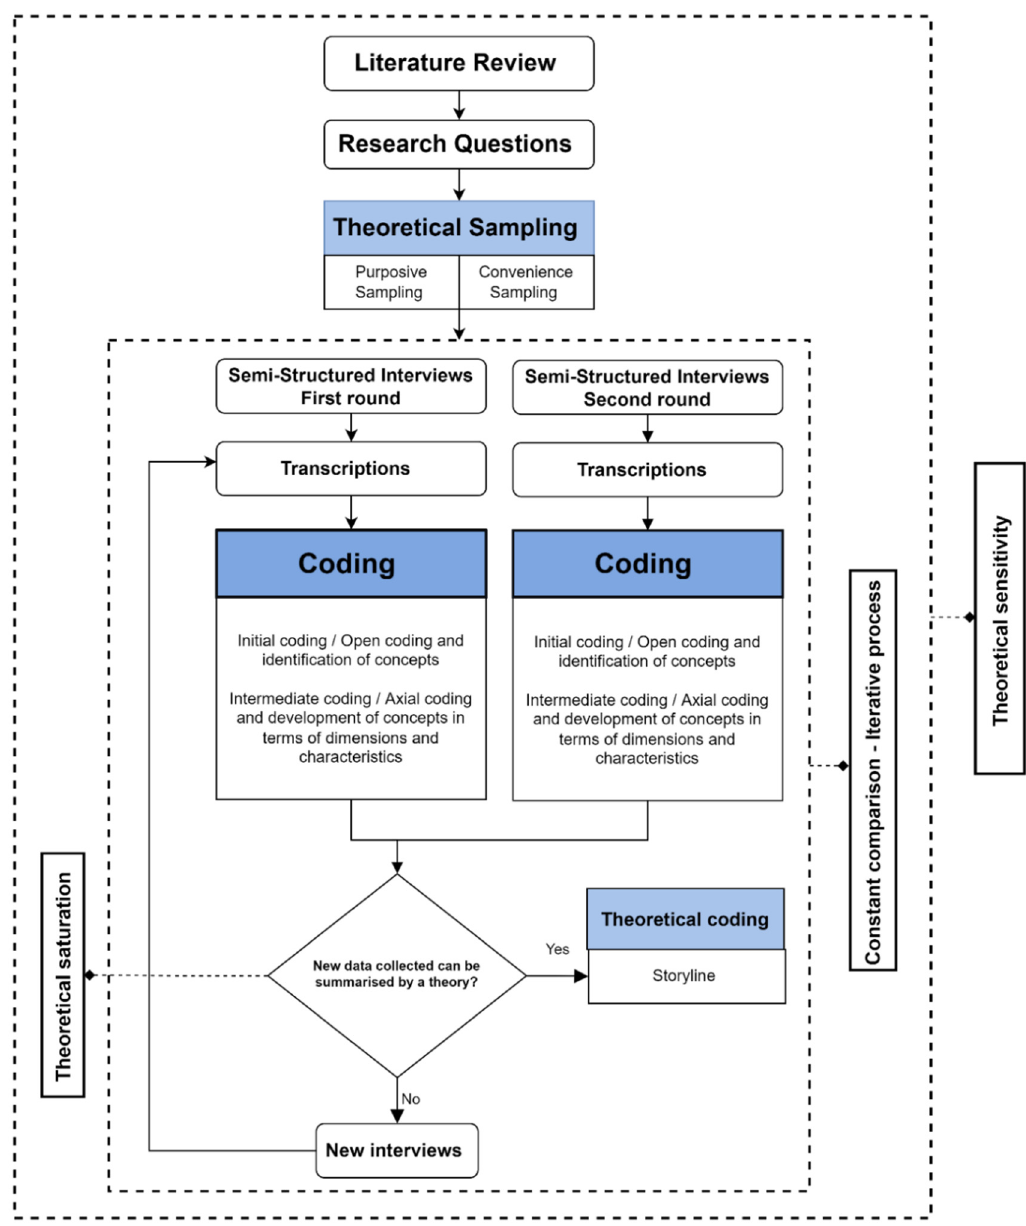
Figure 1. Research framework.